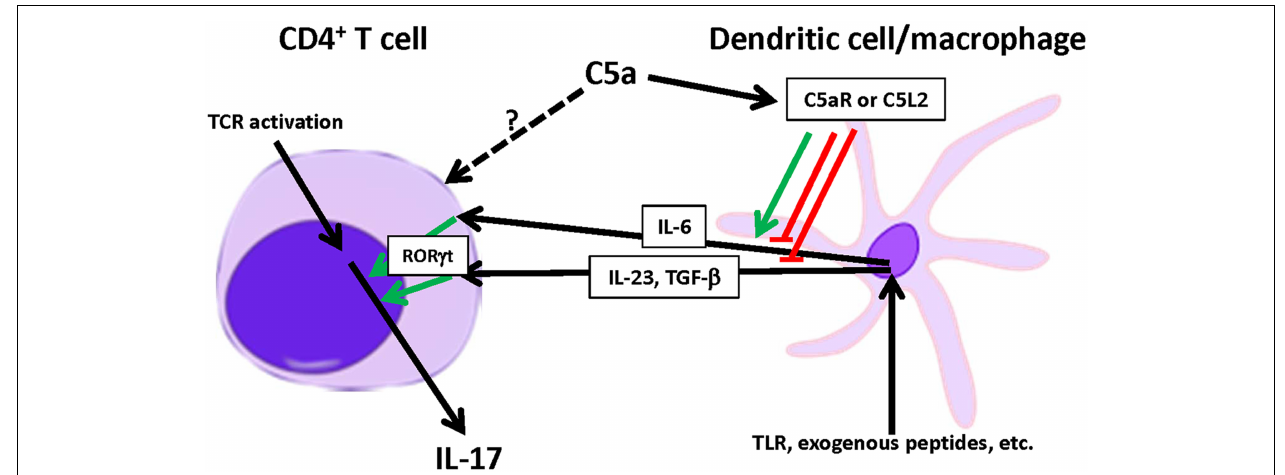
FIGURE 2 | Modulation ofT cell-derived IL-17 by C5a. C5a modulatesT H 17 cell differentiation by altering the local production of IL-23, IL-6, andTGF- β by DCs or macrophages. C5a can either enhance or inhibitT H 17 cell differentiation depending on the inflammatory